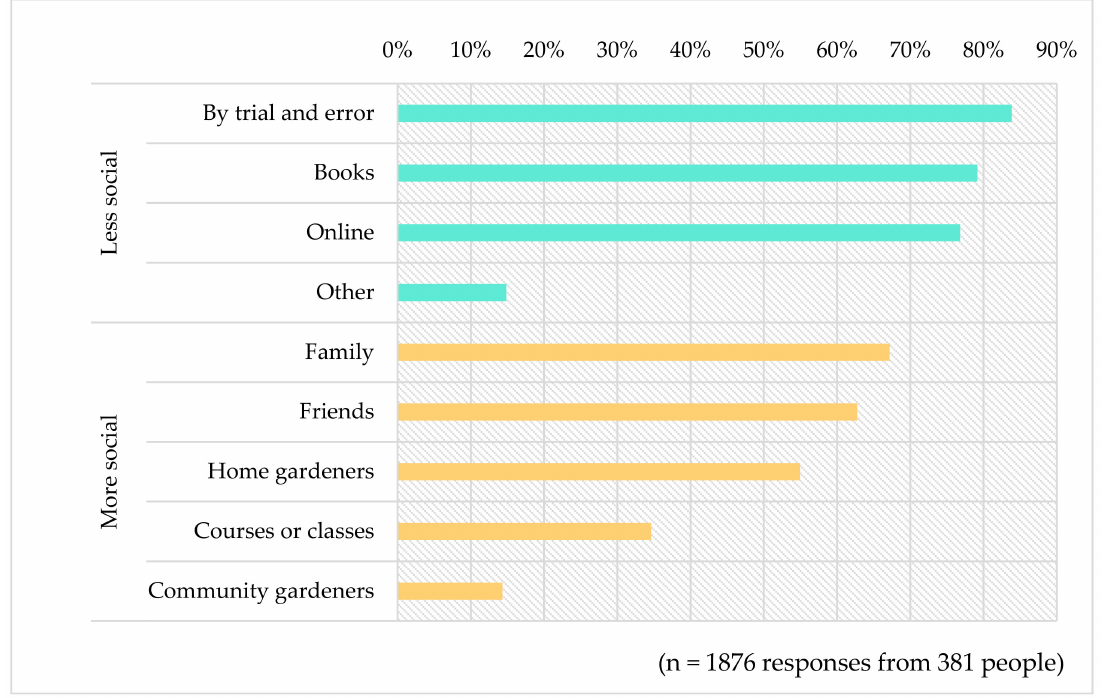
Figure 1. The responses to the question, “from where have you learned about food gardening?” The ‘other’ category mostly refers to sources such as TV shows, magazines or radio. Please note the responses were not mutually